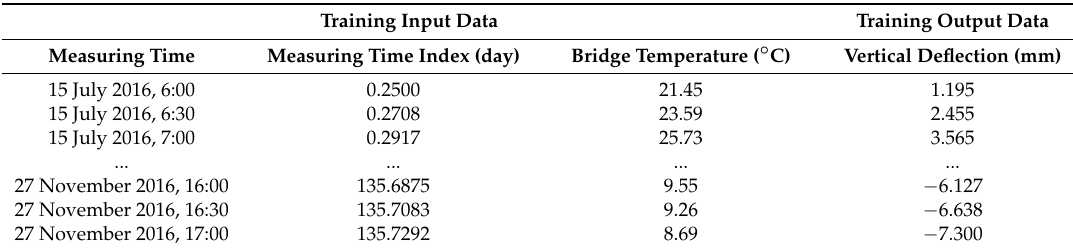
Table 1. Part of the measurement data on Eonyang Arch